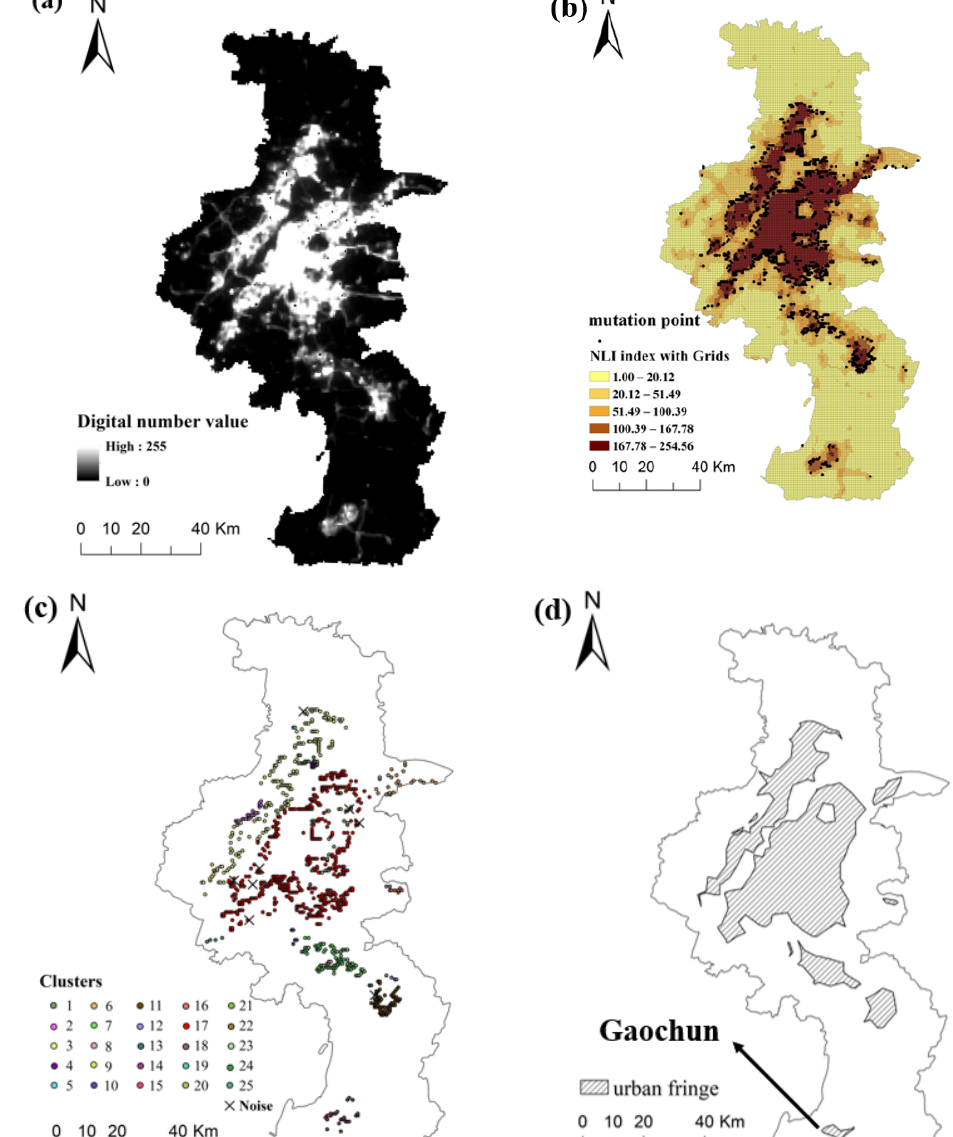
Figure 13. Detection of urban fringe with NASA’s Black Marble product: ( a ) Black Marble nighttime light data (VNP46A4) in 2018; ( b ) Detected mutation points at a grid scale of 0.5 km; ( c ) clustering results by our method; ( d ) Spatial boundaries of urban fringes.